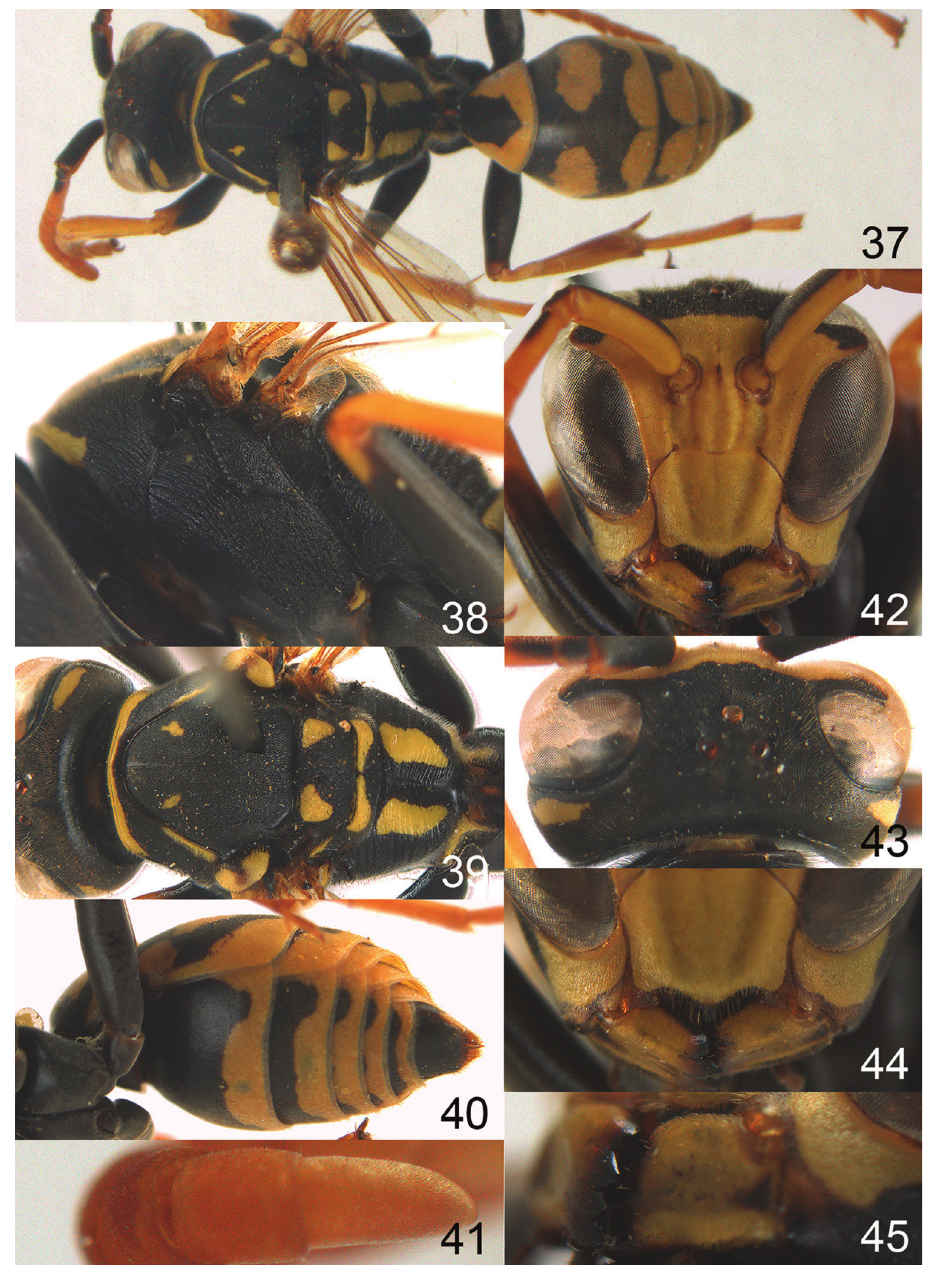
Figures 37–45. Polistes austroccidentalis sp. n. Paratype male. 37 habitus, dorsal view, 38 mesosoma in lateral view 39 mesosoma in dorsal view 40 metasoma in ventrolateral view 41 apex of antenna 42 head in frontal view 43 head in dorsal view 44 lower part of head in frontal view 45 gena and